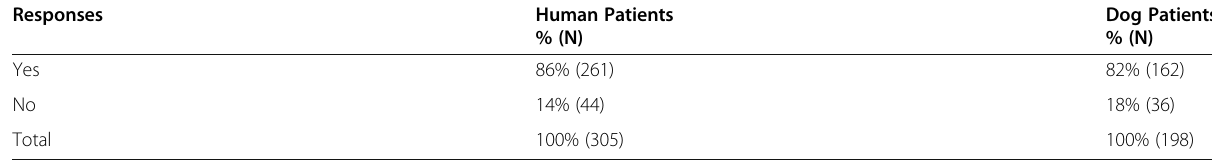
Table 4 Comparison by Met Expectations of Cannabis Products for Human Patients versus Dog Patients Responses Human Patients %